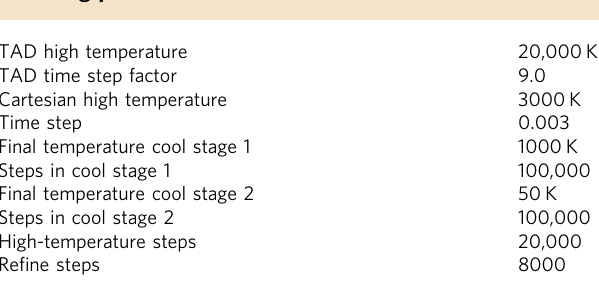
Table 2 Re fi nement parameters used in the